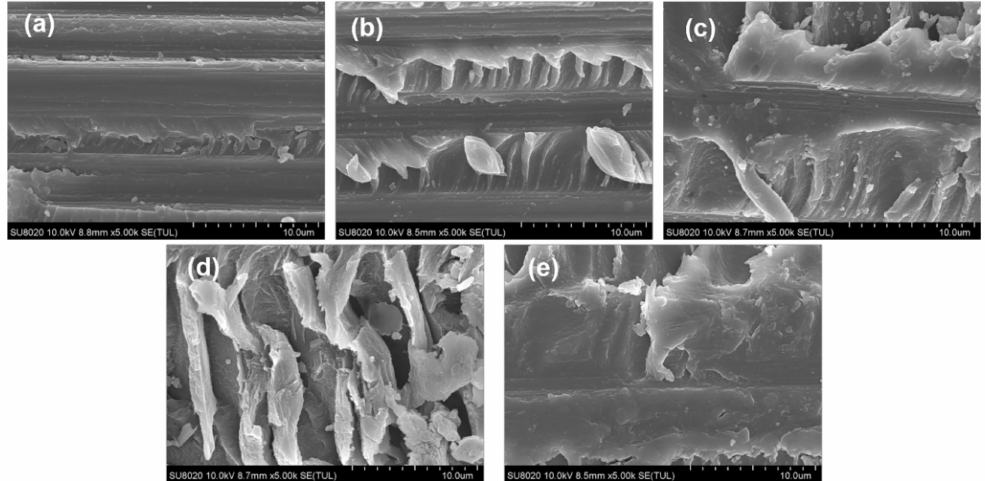
Figure 8. SEM micrographs of mode II fracture surfaces for laminates with different areal densities of interleaves: ( a ) Un- toughened, ( b ) 5 gsm, ( c ) 10 gsm, ( d ) 15 gsm, ( e ) 20